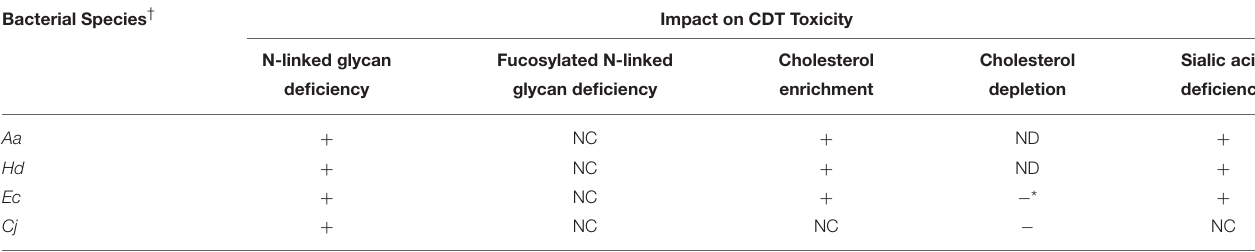
TABLE 1 | Summary showing the effects of membrane components on CDT toxicity in CHO-K1 cells. Bacterial Species